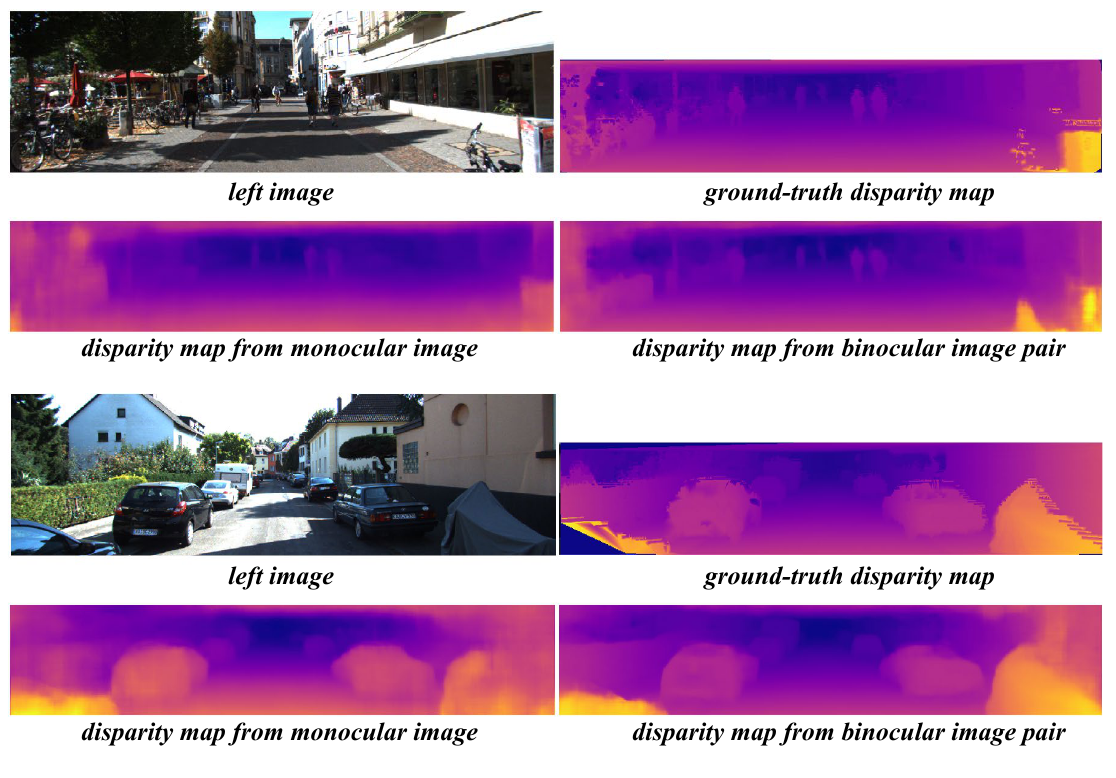
Figure 4. Qualitative results on KITTI